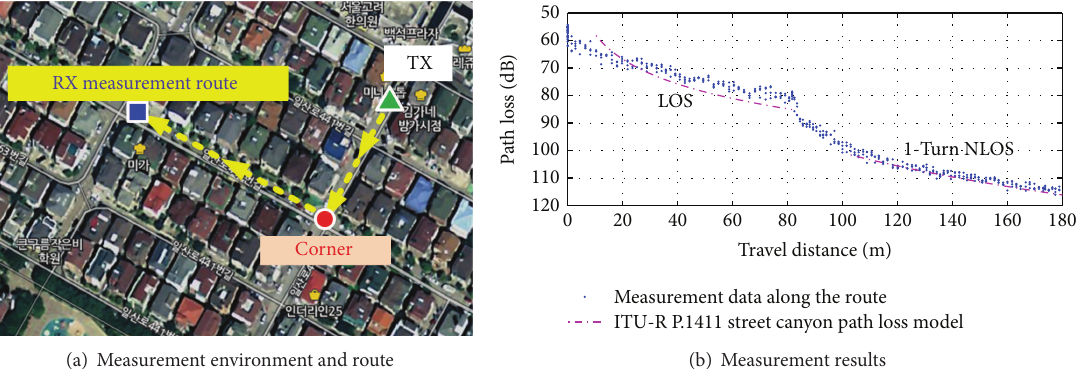
Figure 1: Comparison with measurement data with the ITU-R P.1411 Street Canyon path loss model [17].